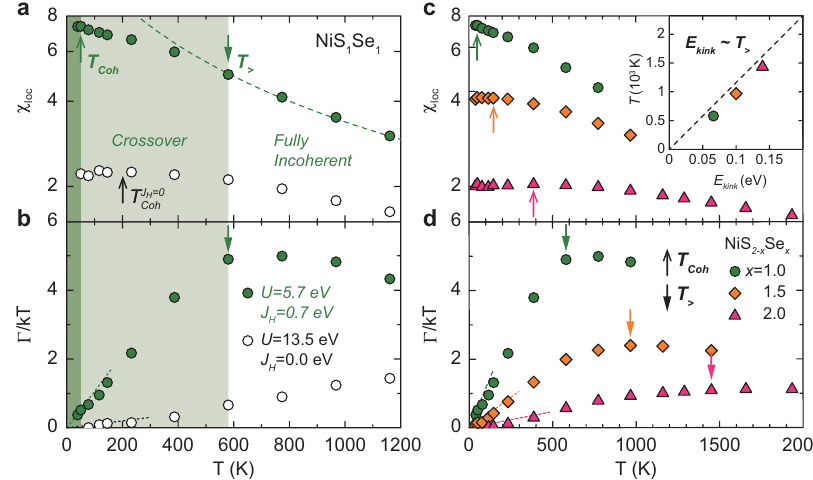
Fig. 4 Local spin susceptibility χ loc and inverse quasiparticle lifetime Γ as a function of temperature. a , b Temperature scale analysis of NiS 1 Se 1 with and without J H , but having the same effective mass. c , d Se content-dependent temperature scale analysis. Upward and downward arrows indicate the coherence temperature T Coh and the coherence – incoherence crossover temperature T > , respectively. Below T > , χ loc deviates from the Curie behavior and Γ / kT starts to decrease gradually. Below T χ Γ / kT shows a linear behavior. The inset indicates the correlation between Coh , loc follows the Pauli behavior and the kink energy scale obtained from Re Σ ( ω ), and T > obtained from Γ / kT